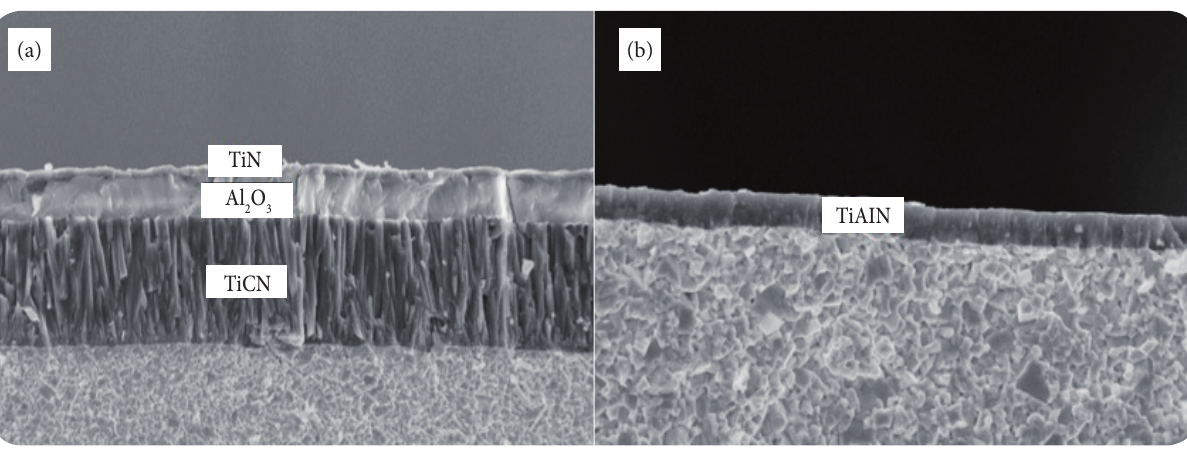
Figure 1. Scanning electron microscopy (SEM) image of (a) medium temperature chemical vapor deposition (MT-CVD) and (b) physical vapor deposition (PVD)-coated inserts (Hill 2012).